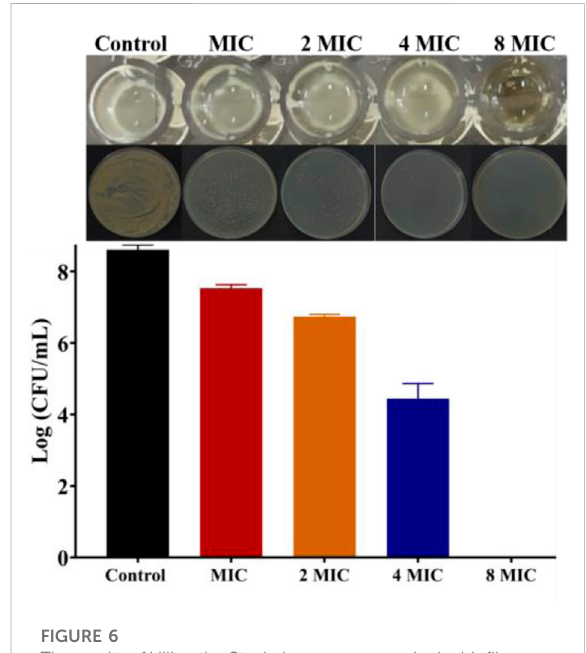
FIGURE 6 The results ofkilling the Staphylococcus aureus in thebio fi lm and count results of killing Staphylococcus aureus in bio fi lm.